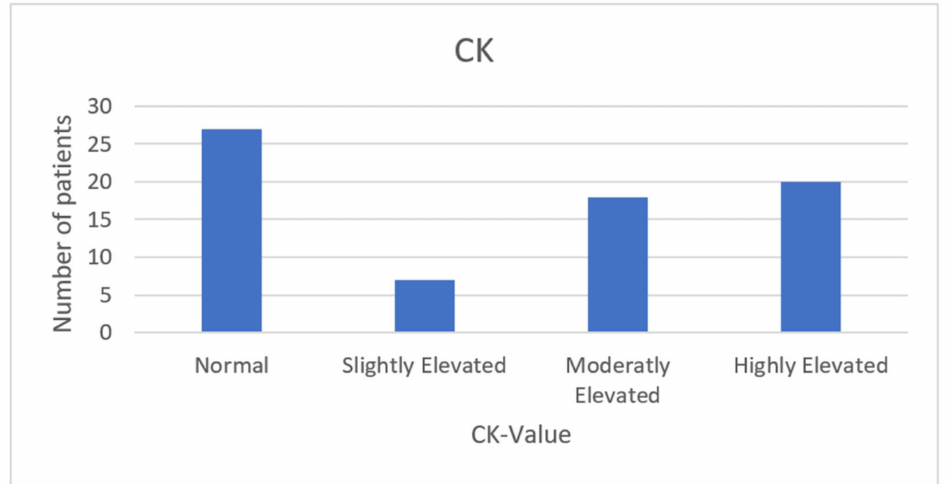
culoskeletal GVHD. The following cutoff values were used: Normal, <280 U/L; slightly increased, 280–500 U/L; moderately increased, 500–2000 U/L; and strongly increased, >2000 U/L.